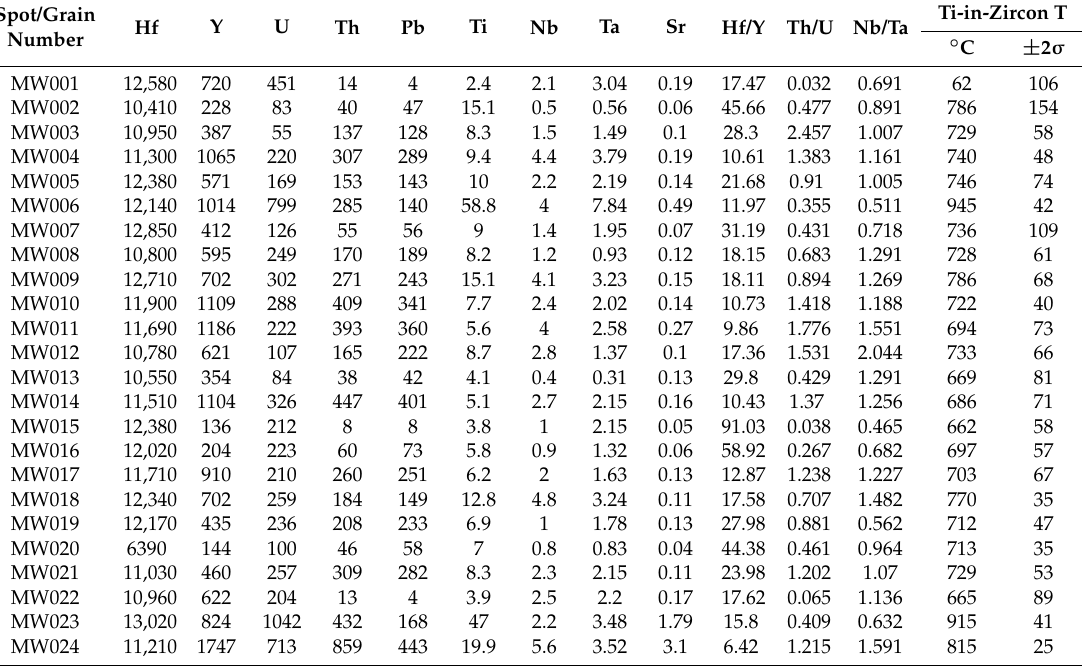
Table 1. Minor and trace elementary abundance (in ppm) in the western Meiganga detrital zircons. Spot/Grain Number